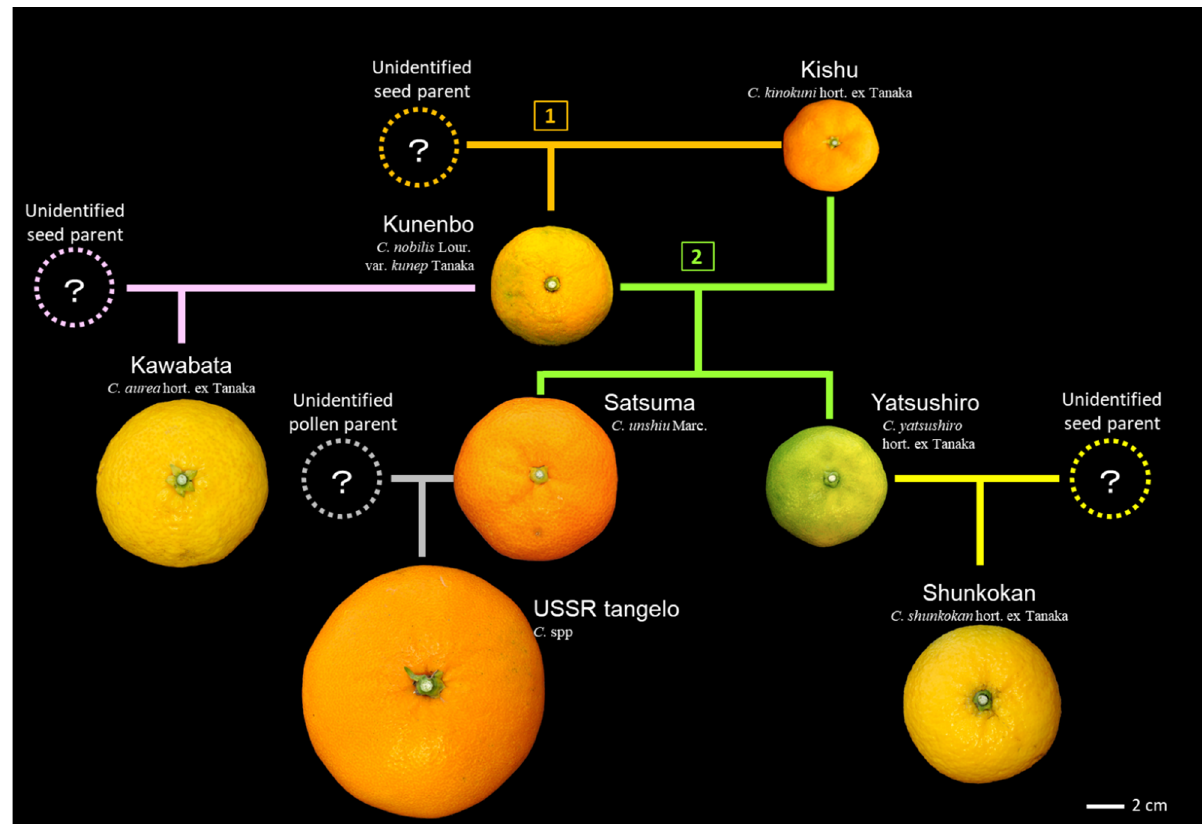
Figure 3. Pedigree of Kishu ( C. kinokuni hort. ex Tanaka) and Kunenbo ( C. nobilis Lour. var. kunep Tanaka). A question mark indicates an unidentified parent. The numbers in squares indicate the first cross of Kishu to produce Kunenbo (1), then the second cross of Kishu with Kunenbo to produce Satsuma and Yatsushiro